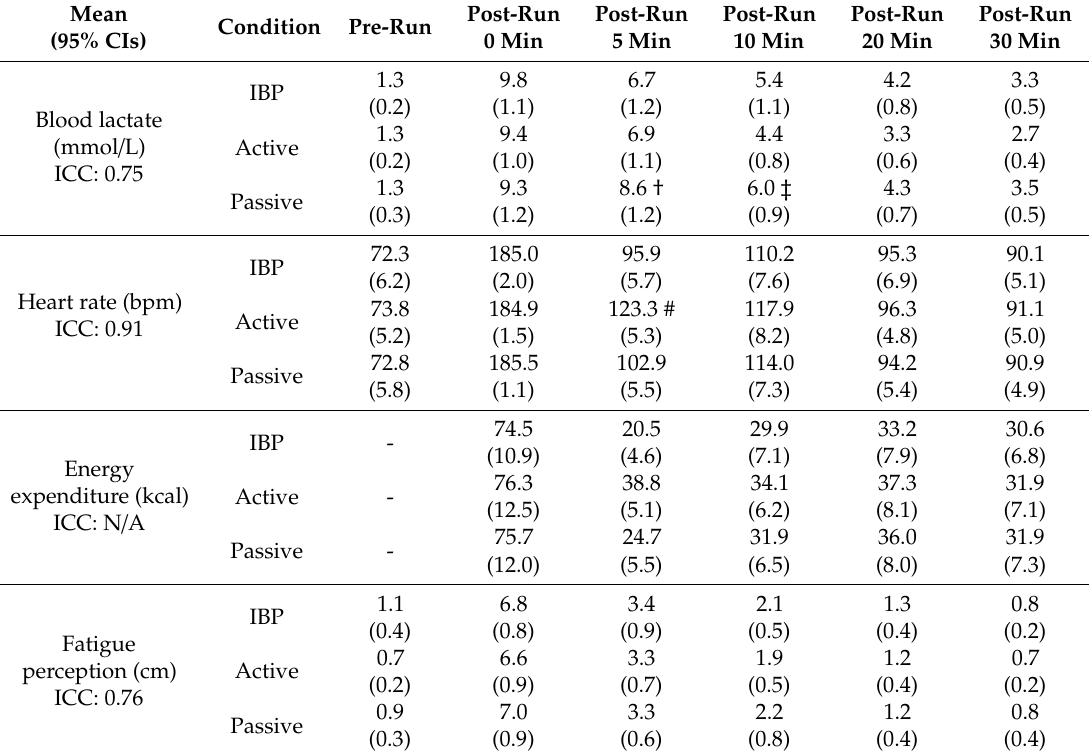
Figure 4. Changes in total energy expenditure regardless of time, IBP: inverted body position; Error bars are upper limits of 95% confidence intervals, † Condition effect (F 2238 = 4.81, p = 0.01): Active was recorded at higher total energy expenditure values compared with the IBP (219 vs. 189 kcal, 14%, p = 0.01, ES = 0.48). Table 1. Changes in heart rate, energy expenditure, blood lactate, and fatigue